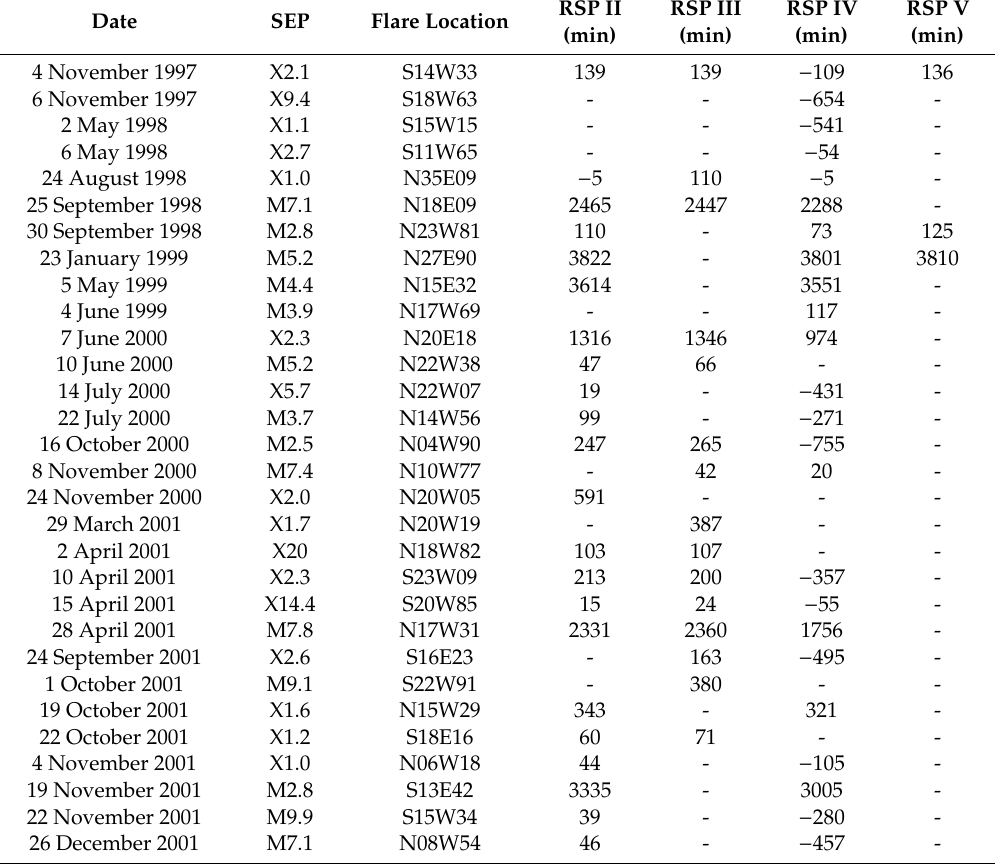
Table 3. Time di ff erences in minutes from the end of the RSP to the start of the solar energetic particle (SEP) events for the period